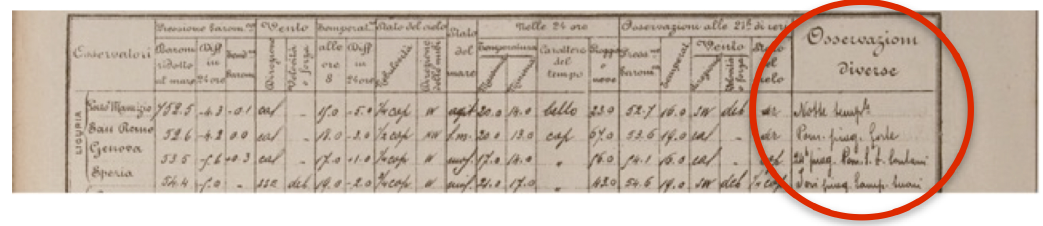
Figure 7. Thunderstorm and lightning activity reports (red circle) on 25 September 1915, as provided by the Italian Royal Meteorological